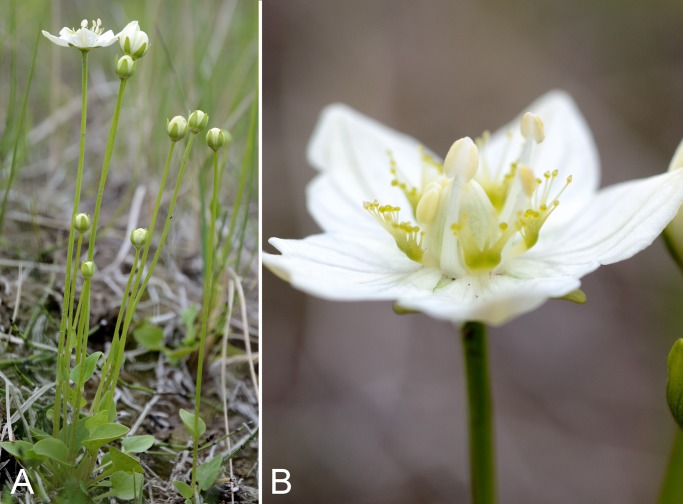
Parnassia palustris subsp. neogaea.(A) Habit, Saarela et al. 4115. (B) Inflorescence, Saarela et al. 4115. Photographs by R. D. Bull.